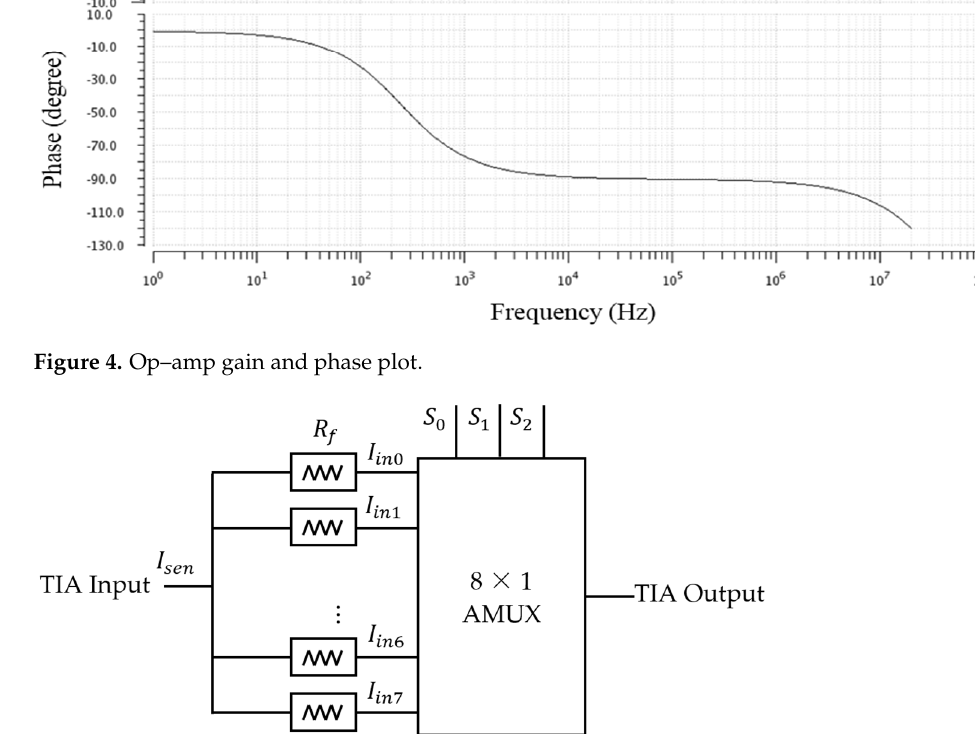
Figure 4. Op − amp gain and phase plot.